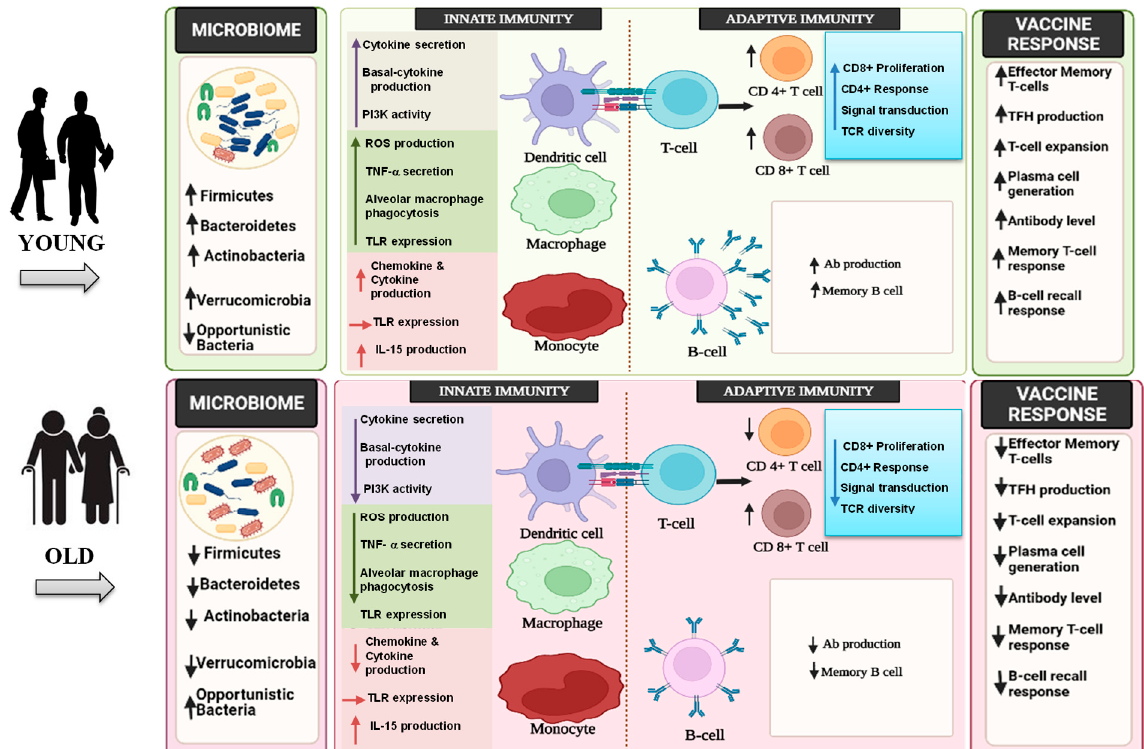
Figure 1. Aging and vaccine response: gut microbiota vis-à-vis innate and adaptive responses. ROS: reactive oxygen species; TLR: toll-like receptors; IL: interleukin; TNF: tumor-necrosis factor; Ab: antibodies; TCR: T-cell receptor; TFH: T-follicular helper cells; ↑ : higher/increased; ↓ : lower/decreased.